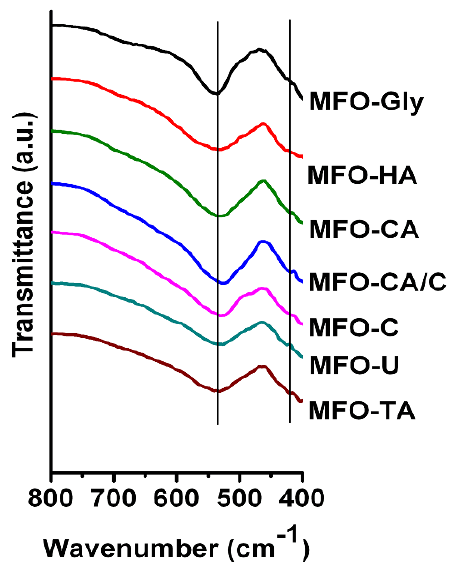
Figure 4. IR spectra of magnesium ferrite powder synthesized at 973 K.